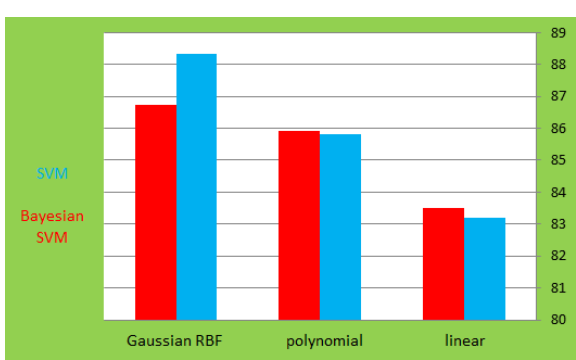
Figure 2. The Accuracy of the Models in Distinguishing Alzheimer's Patients From Healthy Controls.